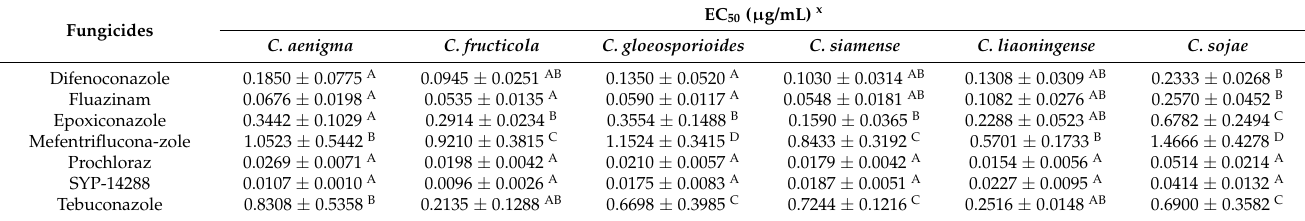
Table 5. Sensitivity of Colletotrichum species to seven